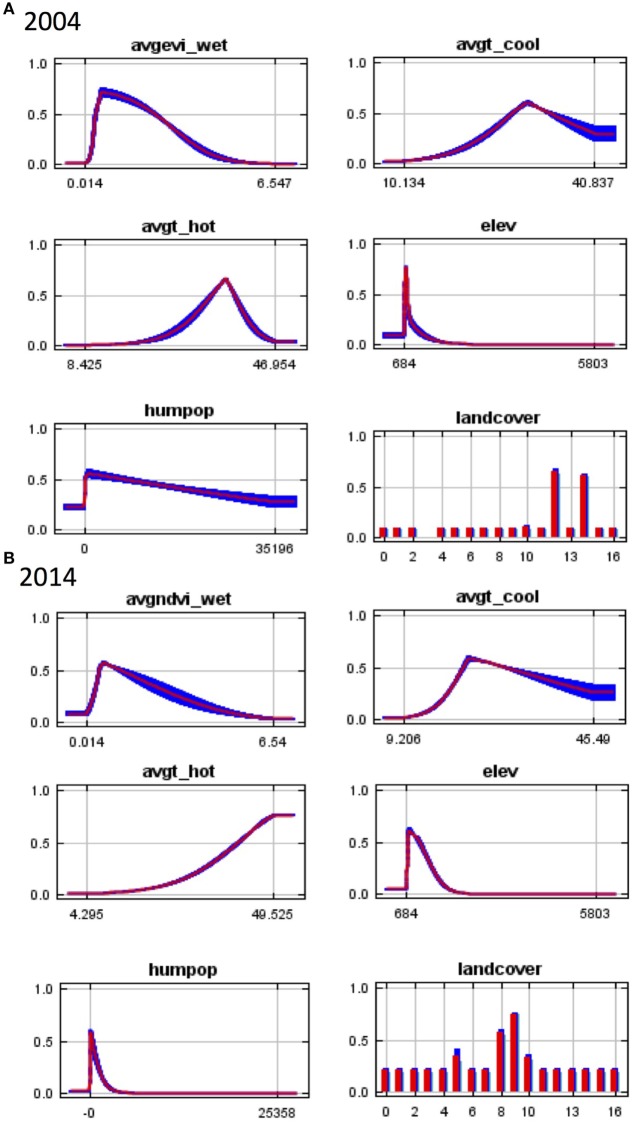
Response curves for Maxent models in (A) 2004 and (B) 2014 showing the dependence of predicted suitability for Anopheles arabiensis occurrence on the selected variable accounting for dependencies induced by correlations with other variables. Wet season NDVI (avgndvi_wet), wet season EVI (avgevi_wet), mean temperature of the warmest month (avgt_hot), mean temperature of the coldest month (avgt_cool), elevation (elev), human population density (humpop). NDVI, normalized differential vegetation index; EVI, enhanced vegetation index.